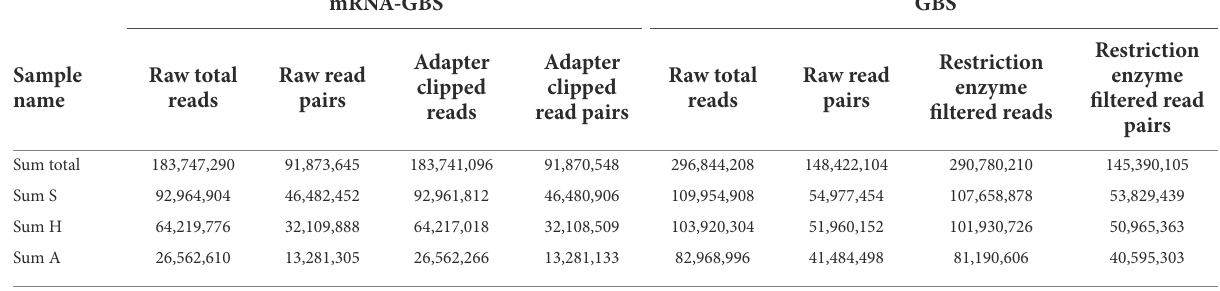
TABLE 2 Number of raw reads retained in mRNA-GBS and GBS analysis after each filtering step for Trifolium pratense samples from the three biodiversity exploratory sites in Germany (S, Schorfheide-Chorin; H, Hainich-Dün; A, Swabian Alb). mRNA-GBS